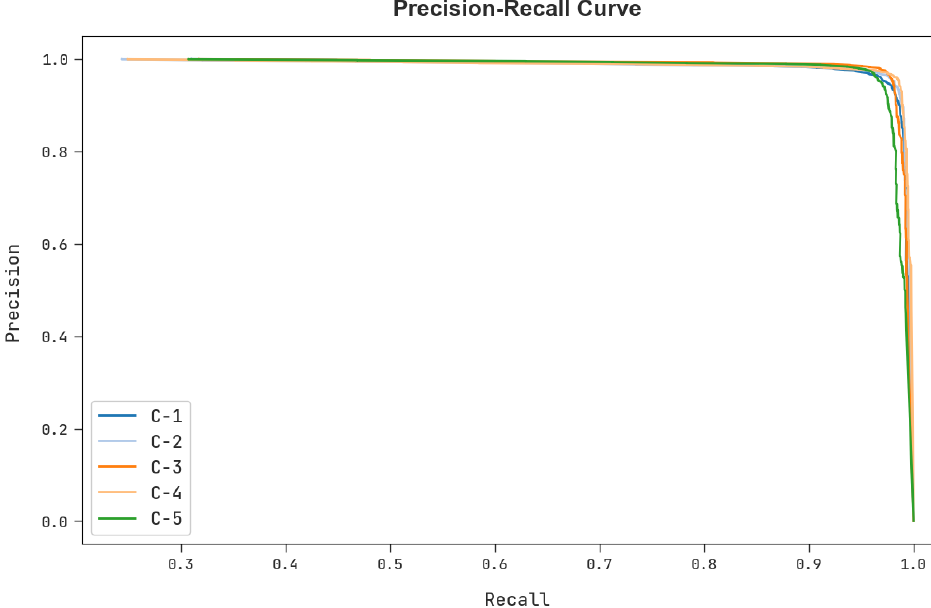
Figure 7. Precision recall analysis of AOEDBC-DL system.